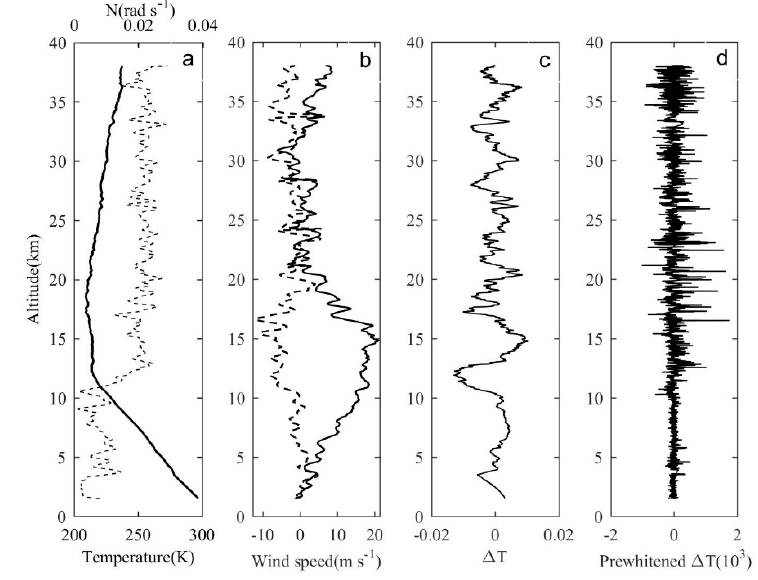
Figure 2. ( a ) An example of temperature (solid line) and buoyancy frequency (dashed line), ( b ) horizontal wind speed component (solid line: zonal wind speed component; dashed line: meridional wind velocity component), ( c ) normalized temperature disturbance component, and ( d ) pre-whitened normalized temperature disturbance profiles (from left to right) observed on the night of September 21, 2019 during the balloon ascent.